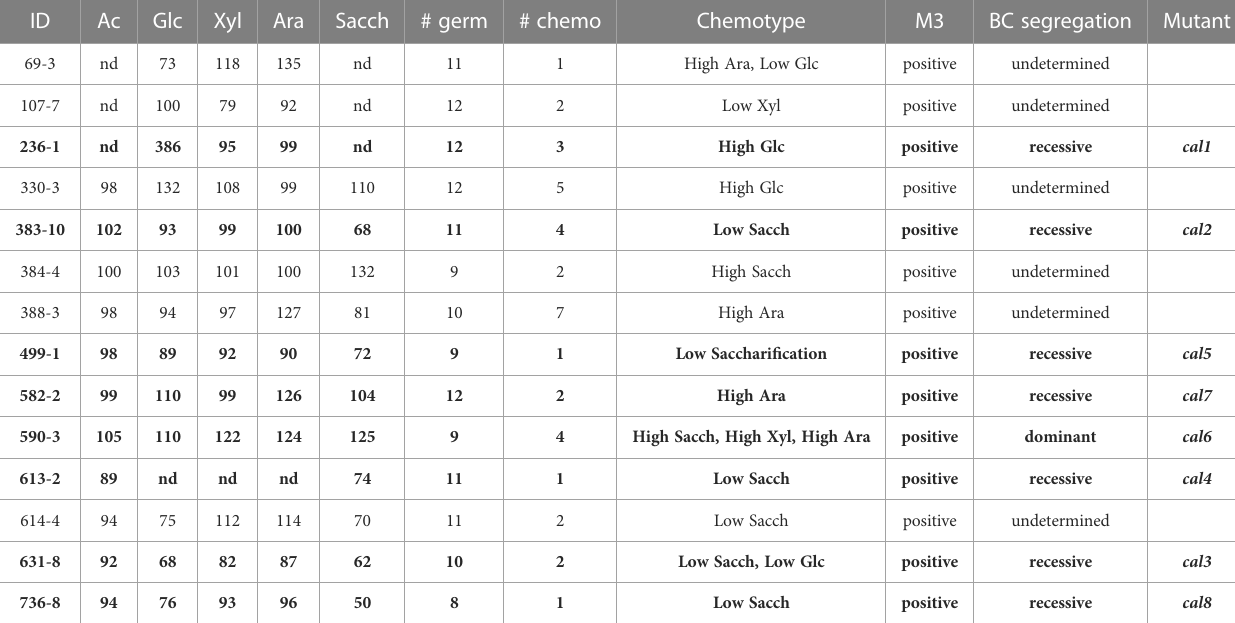
TABLE 1 Summary cal mutant